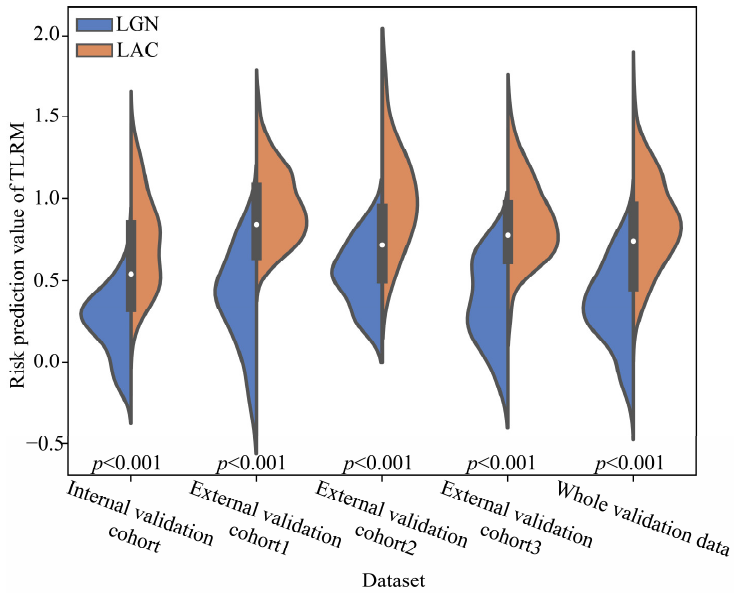
Figure 4. The risk prediction value of distributions of TLRM in the four validation cohorts and whole validation data. Note: TLRM, transfer learning radiomics model; LAC, lung adenocarcinoma; LGN, lung granulomatous nodule.